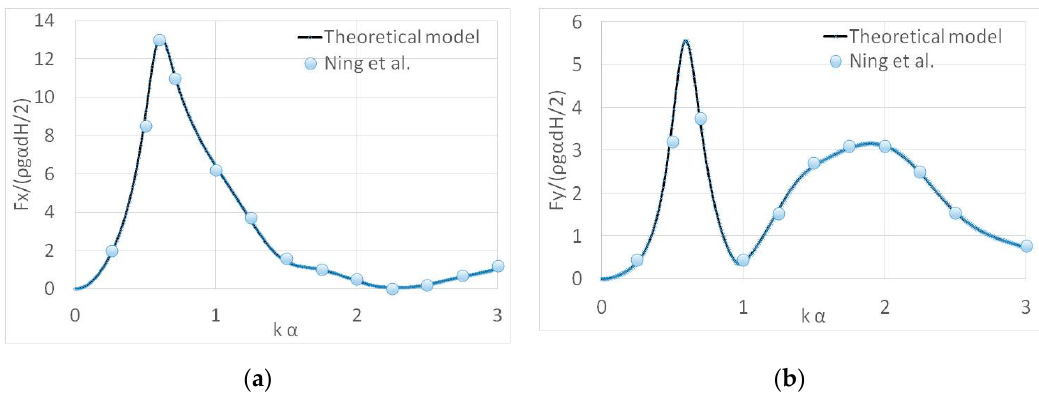
Figure 3. Horizontal-exciting forces on a bottom fixed cylindrical body placed in front of an orthogonal breakwater using the method of images: ( a ) horizontal-exciting force on x -axis; ( b ) horizontal-exciting force on y -axis